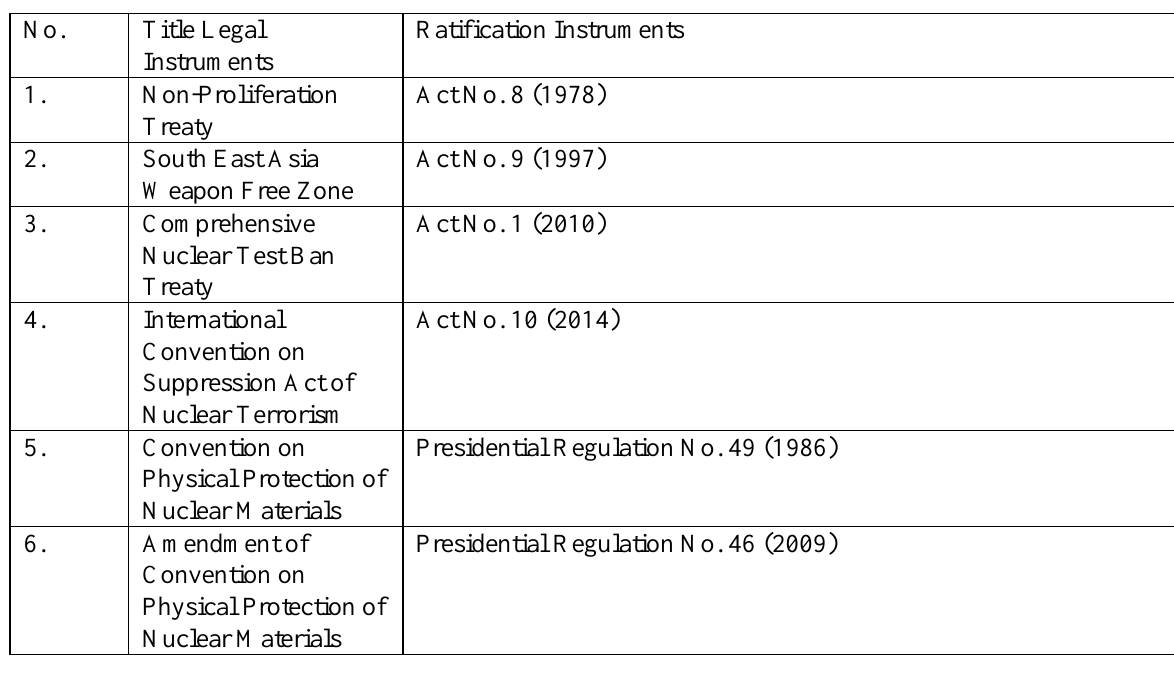
Table 1. Ratification of International Legal